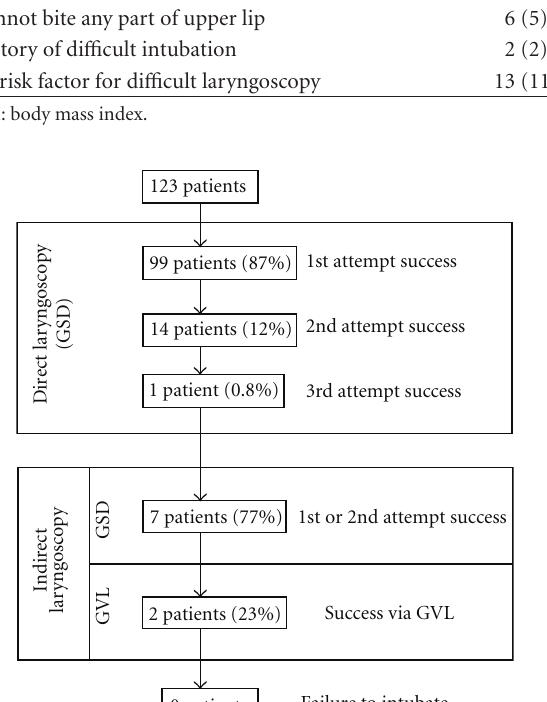
Figure 3: Description of airway management in patients using the GlideScope Direct.